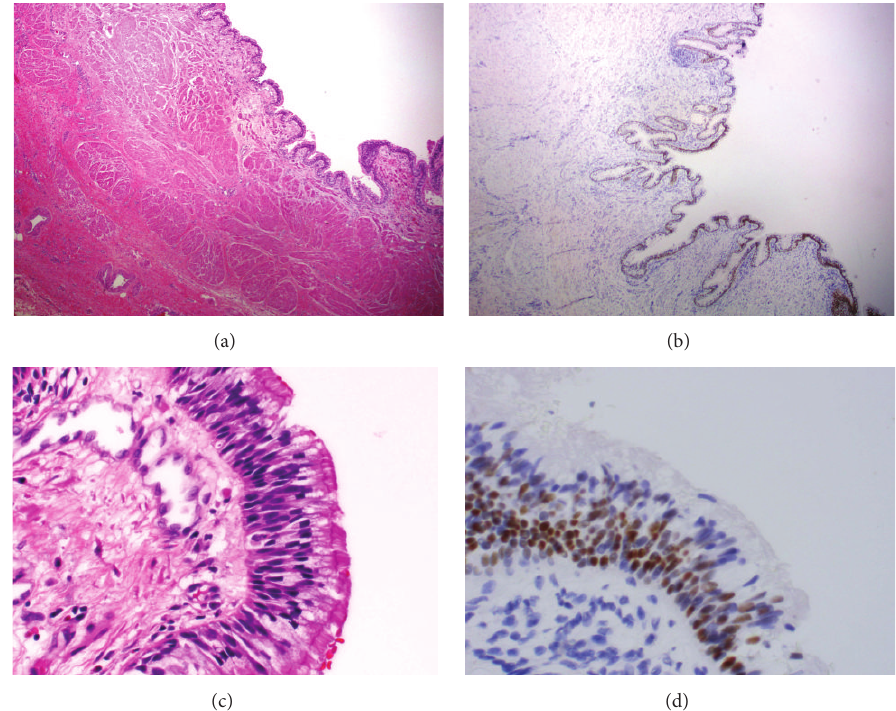
Figure 2: (a) Cystic lesion lined by pseudostratified ciliated columnar epithelium with longitudinal and circular smooth muscle layers (10x). (b) TTF-1 immunohistochemistry highlights the lung type II pneumocytes (10x). (c) High magnification of the pseudostratified ciliate columnar epithelium (60x). (d) High magnification highlights the nuclear staining of TTF-1